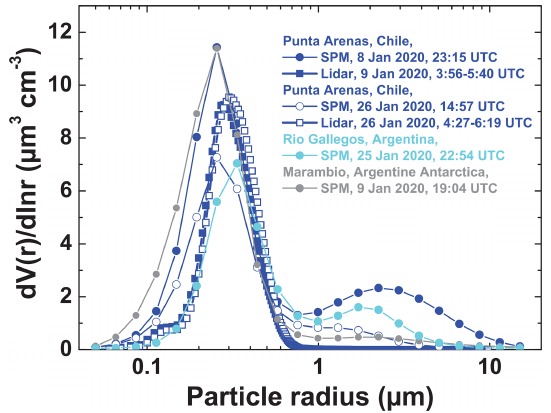
Figure 5. Normalized volume size distributions of smoke particles derived from column (tropospheric + stratospheric) AERONET sun photometer (SPM) observations at Punta Arenas, Rio Gallegos, and Marambio in January 2020. In addition, size distributions obtained from the inversion of lidar-derived optical properties (squares) in the well-defined smoke layers are shown. Base and top heights of the smoke layers were 12.8 and 15.7km on 9 January 2020 and 19.3 and 22.9km on 26 January 2020, respectively. The lidar-derived size distributions show an accumulation mode only; a distinct coarse mode is